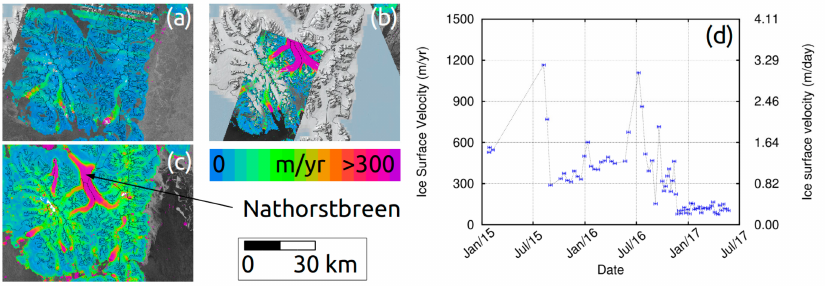
Figure 10. Ice surface velocity maps for Strongbreen on Spitsbergen (Svalbard) from Sentinel-1 data of the time periods 19/09/2015 to 01/10/2015 ( a ) and 16/02/2017 to 28/02/2017 ( b ) and time-series of Sentinel-1 velocity ( c ). The arrow points to the location used for the time series.